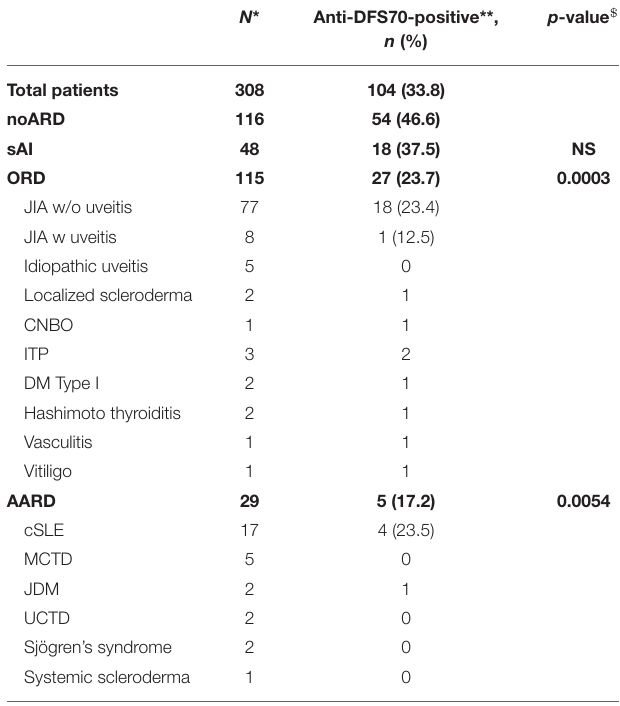
TABLE 1 | Prevalence of anti-DFS70 antibodies among patients with positive ANA testing in immune fluorescence